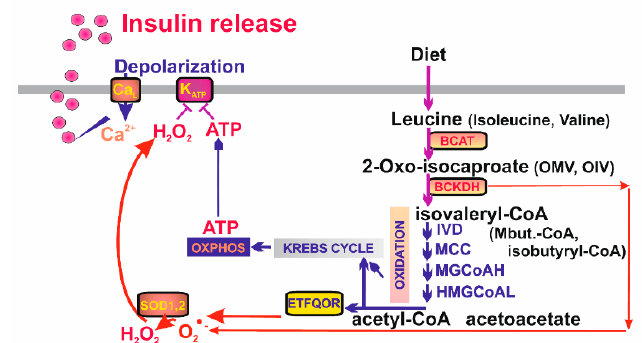
Figure 5. Mitochondrial redox signaling as essential part of branched-chain keto-acid- stimulated secretion of insulin. Branched-chain keto-acids are metabolized by a series of catabolic reactions leading to production of substrates fueling Kreb‘s cycle and the mitochondrial respiratory chain. ATP and H 2 O 2 then cause closure of the ATP-dependent K + channels (K ATP ) on the plasmatic membrane, membrane depolarization and activation of the voltage-gated Ca 2+ channels (Ca L ) setting off the canonical pathway of insulin release.